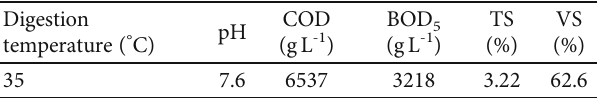
Figure 3: Schematic of the double-pipe heat exchanger. Table 2: Characteristics of the biogas